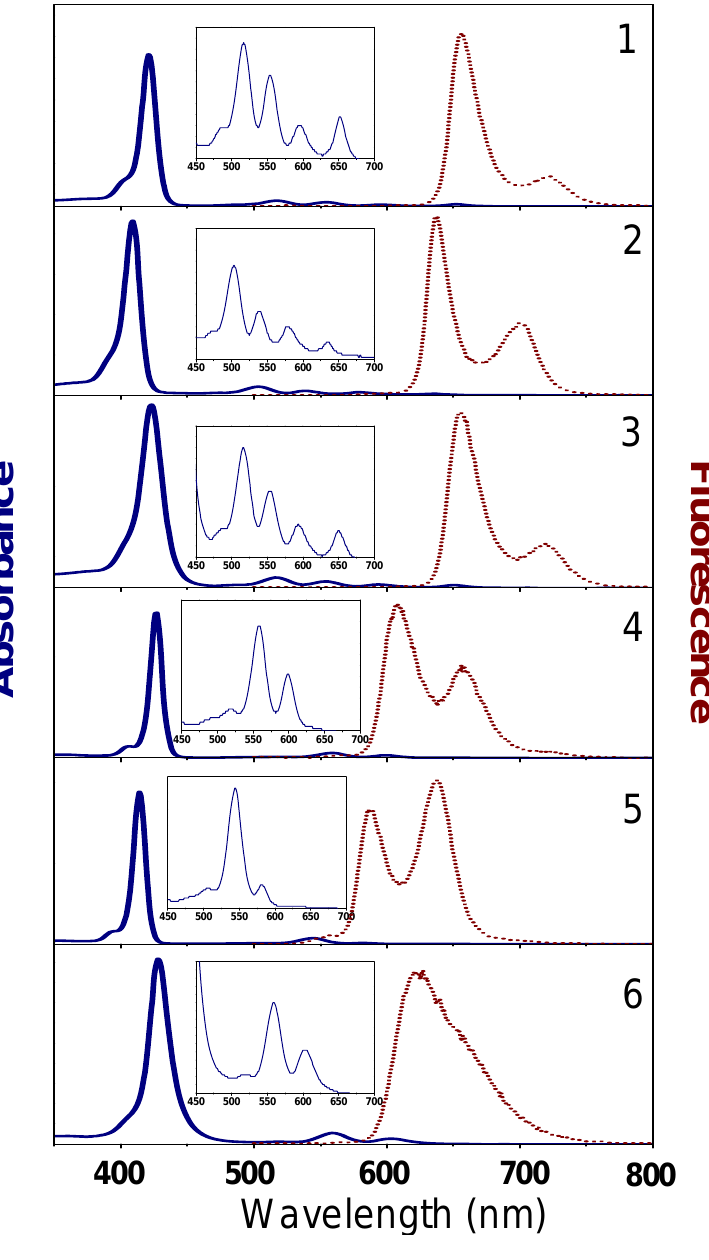
Figure 6. Absorption and emission spectra of the compounds in THF solution. The absorption and fluorescence maxima are collected in Table